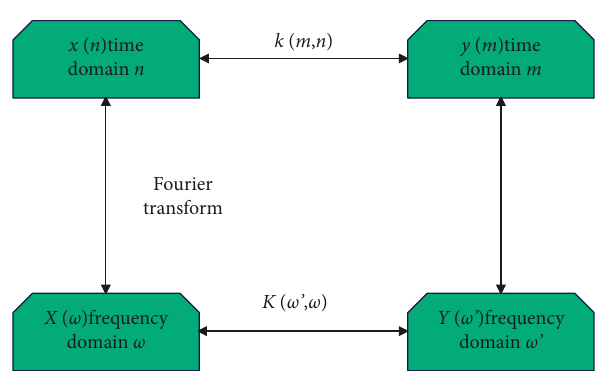
Figure 3: Frequency domain mapping in a multisampling